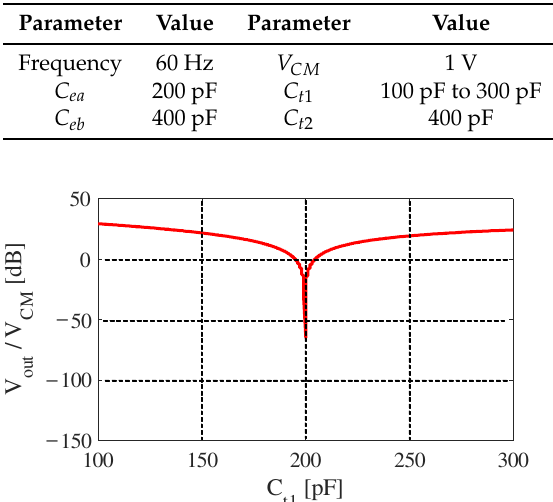
Figure 7. Simulated result of output voltage normalized to CM noise for “DTC Bypath” under Table 3’s